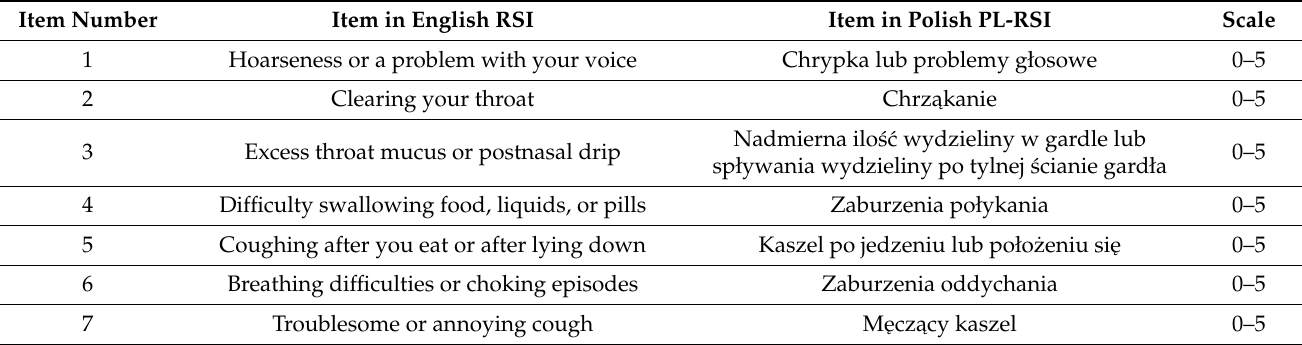
Table 1. Final version of the translated PL-RSI